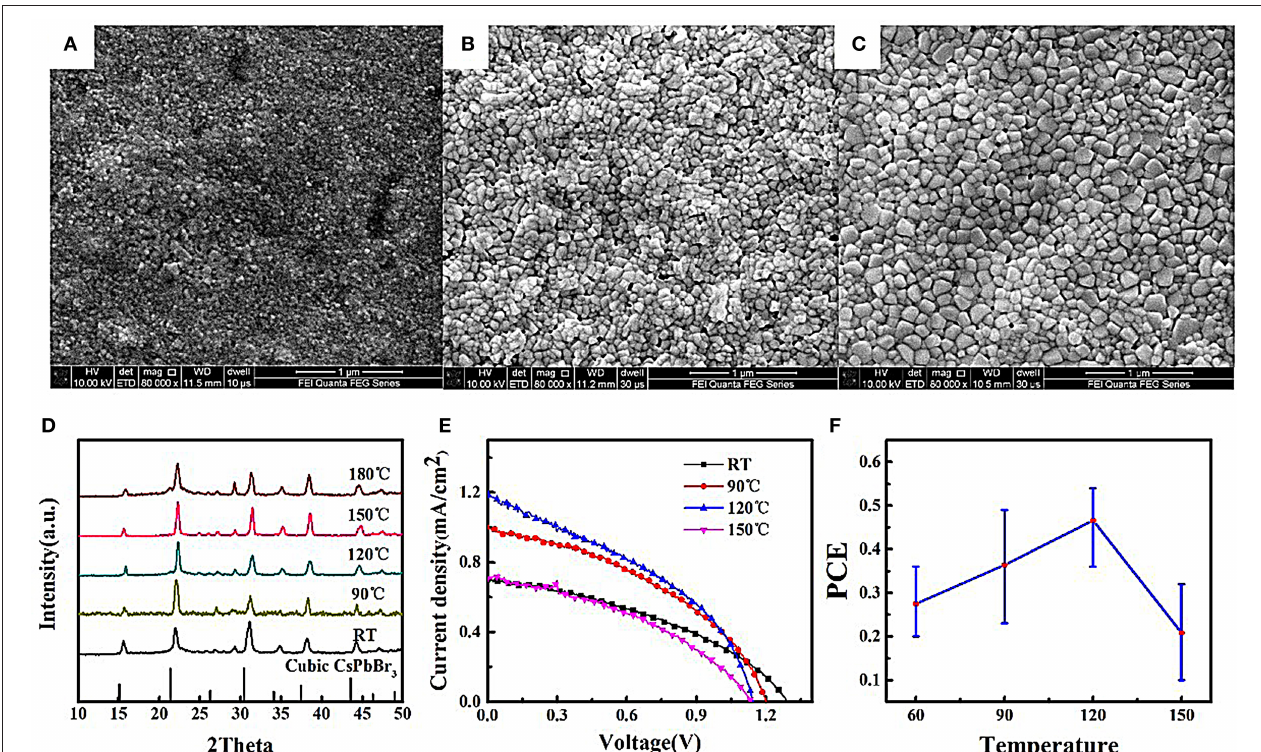
FIGURE 3 | The effects of annealing temperature on morphology and crystal of CsPbBr 3 NC films and solar cell performance. SEM images of (A) as-prepared (B) 90 ◦ C and (C) 180 ◦ C. (D) XRD patterns, (E) current density-voltage curves of NC film solar cells under AM 1.5 illumination, (F) the relationship between PCE and anneal